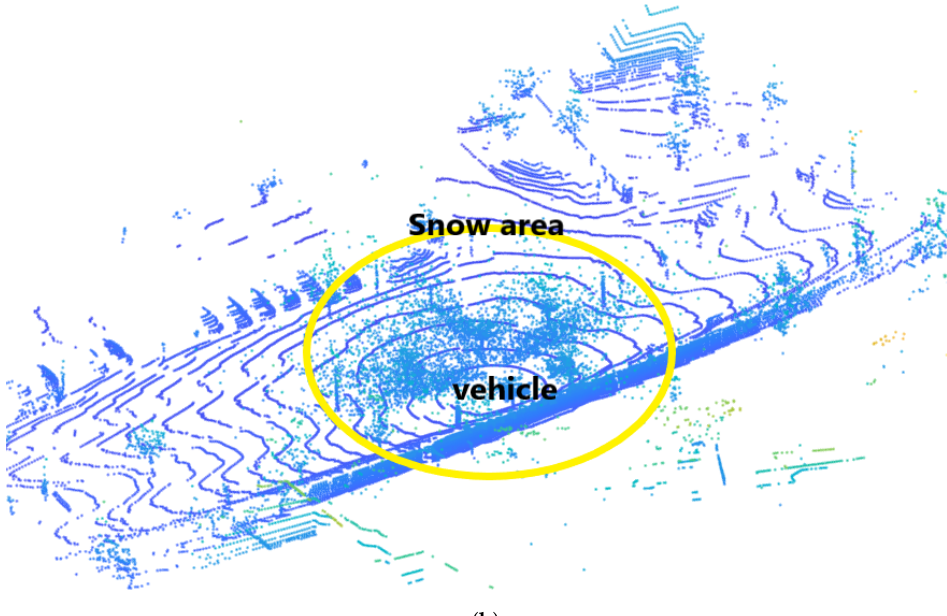
Figure 1. Raw data from LiDAR point clouds. ( a ) A vehicle under clear weather conditions from the Pandaset dataset. Objects around the vehicle are clearly captured. ( b ) A vehicle under in snows condition from the Canadian Adverse Driving Conditions Dataset. The snow of the cluster is marked in a yellow circle. Noise from snow particles affects vehicle